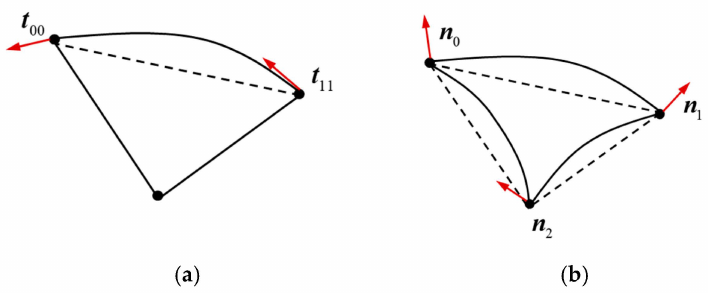
Figure 1. Definition of AMF surface triangles: ( a ) tangent vector of the vertex; ( b ) normal vectors of the vertices.